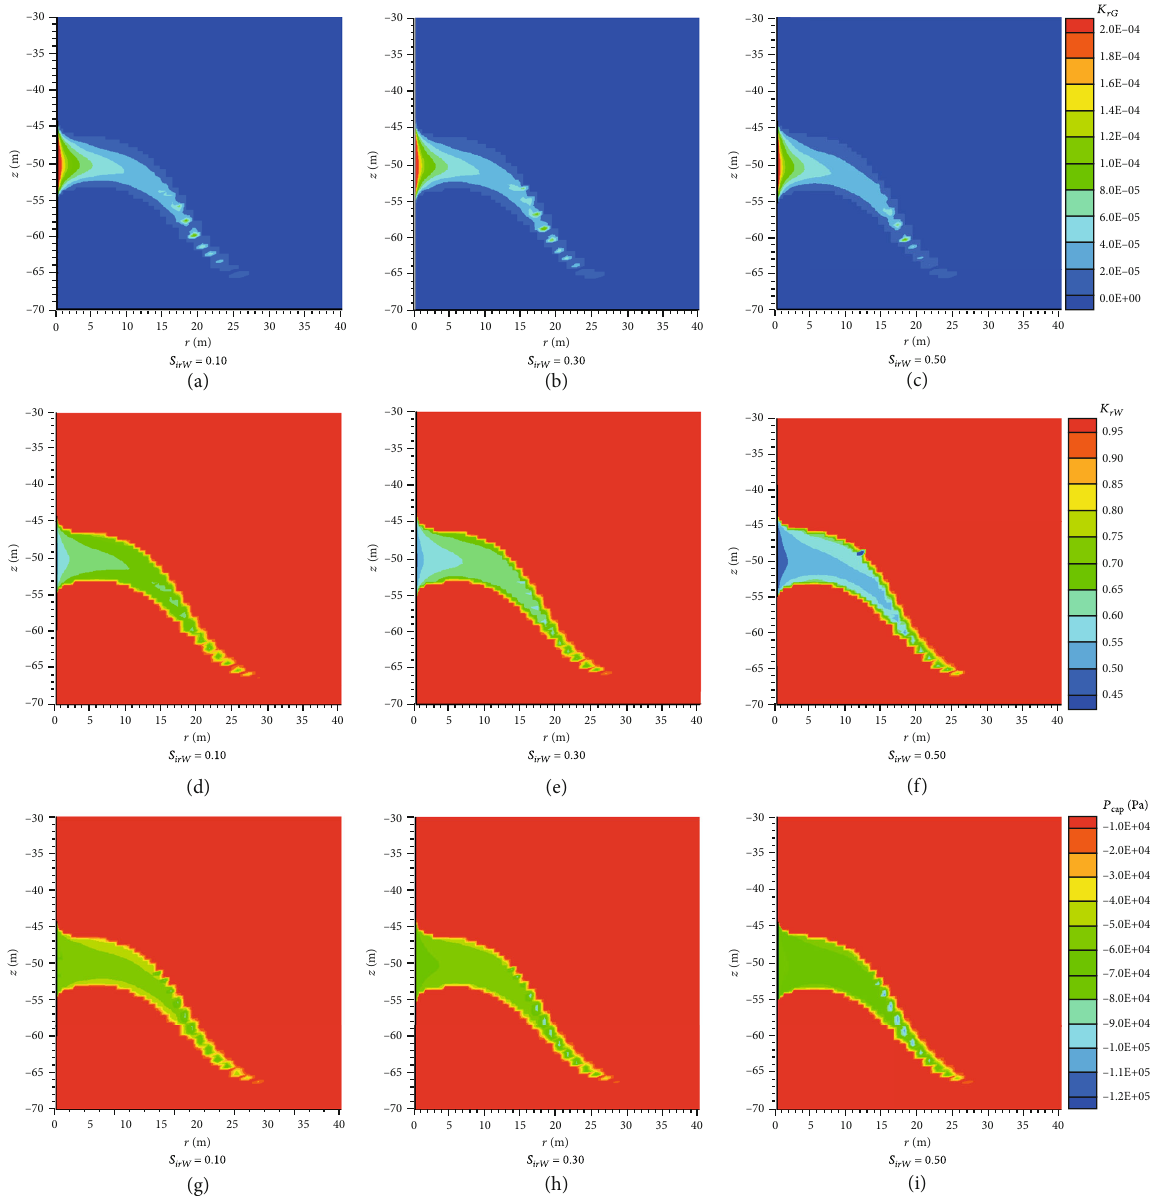
Figure 10: Comparison of gas relative permeability K with di ff erent irreducible water saturation S